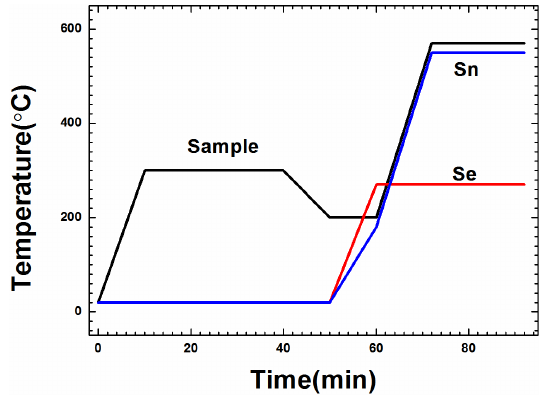
Figure 1. The temperature profiles of the selenization process.